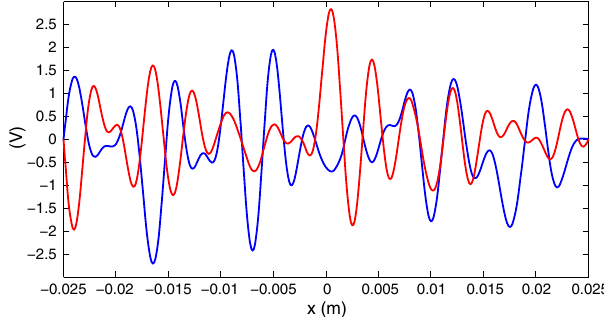
ˆ E k; s; x Þ at y ¼ 0 , at 5 m into sp ð